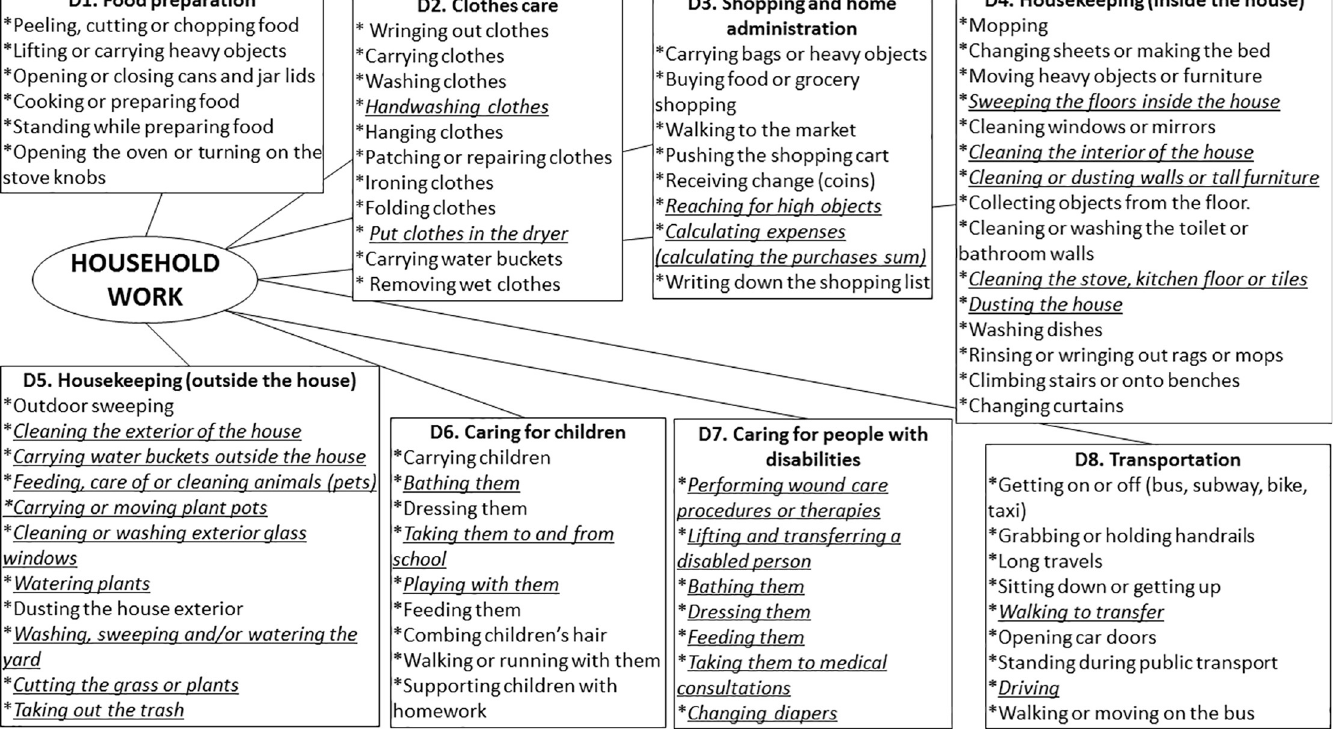
Experts-committee evaluation/selection of the instructions and of the items . Results of 11